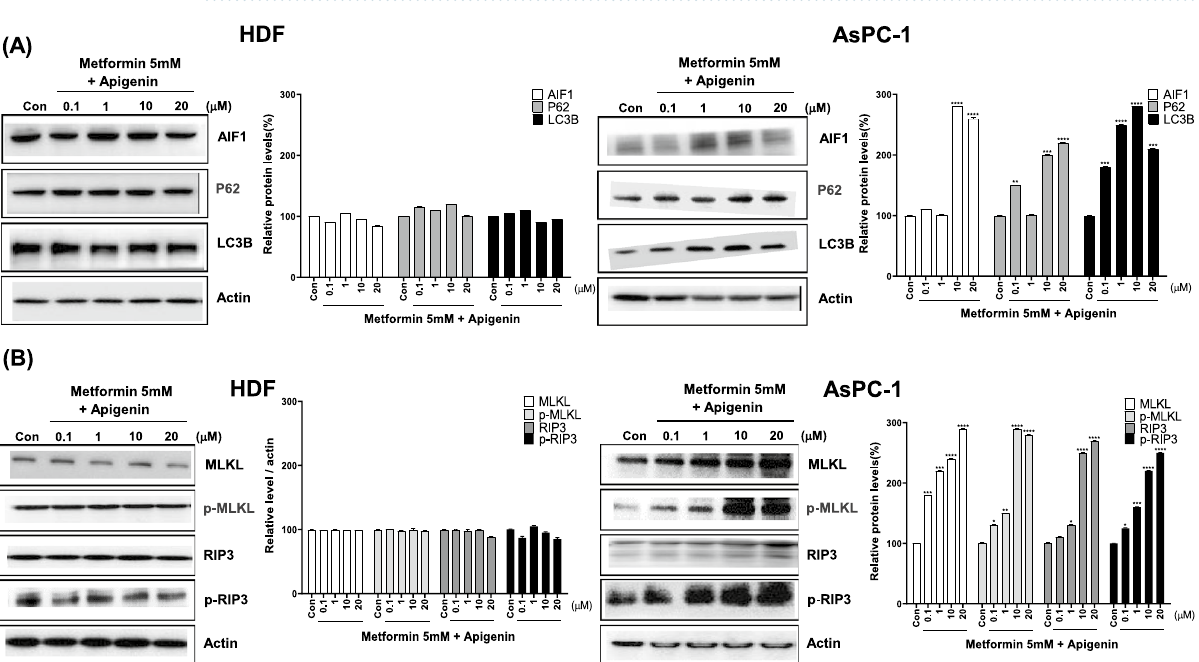
Figure 6. Levels of autophagy- and necroptosis-related proteins in metformin/apigenin-combination treated AsPC-1 and HDF cells. AsPC-1 and HDF cells were treated with metformin (5 mM) and apigenin (0.1, 1, 10 or 20 μM) for 48 h. Cell extracts were prepared and subjected to western blot analysis. Autophagy-related proteins were analyzed with anti-AIF, P62 and LC3B antibodies. Necroptosis-related proteins were analyzed with anti- MLKL, p-MLKL, RIP3 and p-RIP3 antibodies. Three different measurements were performed for each sample. Statistical significance is indicated as * p < 0.05, ** p < 0.01, *** p < 0.001, and **** p < 0.0001 compared with control